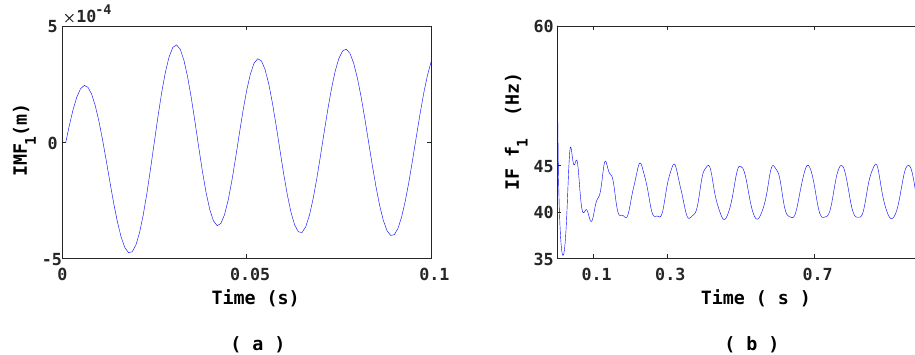
Figure 14. ( a ) IMF 1 (t) mode. ( b ) IF f 1 ( t ) .